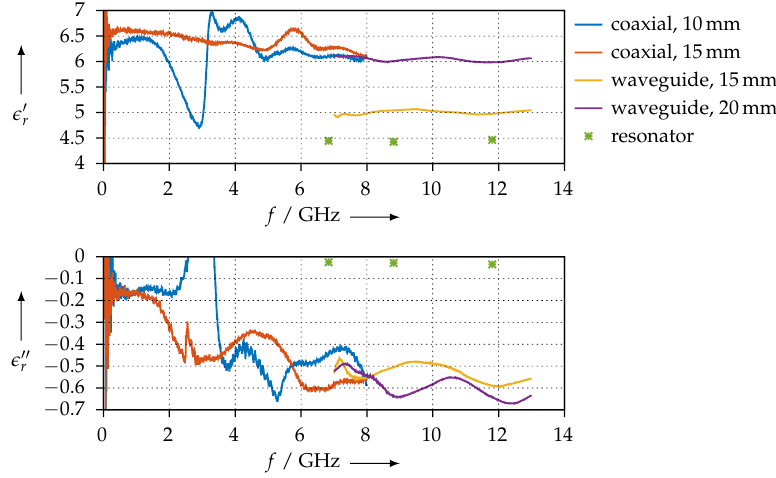
Figure 23. Real ( (cid:101) (cid:48) r ) and imaginary ( (cid:101) (cid:48)(cid:48) r ) parts of the permittivity for the SSP